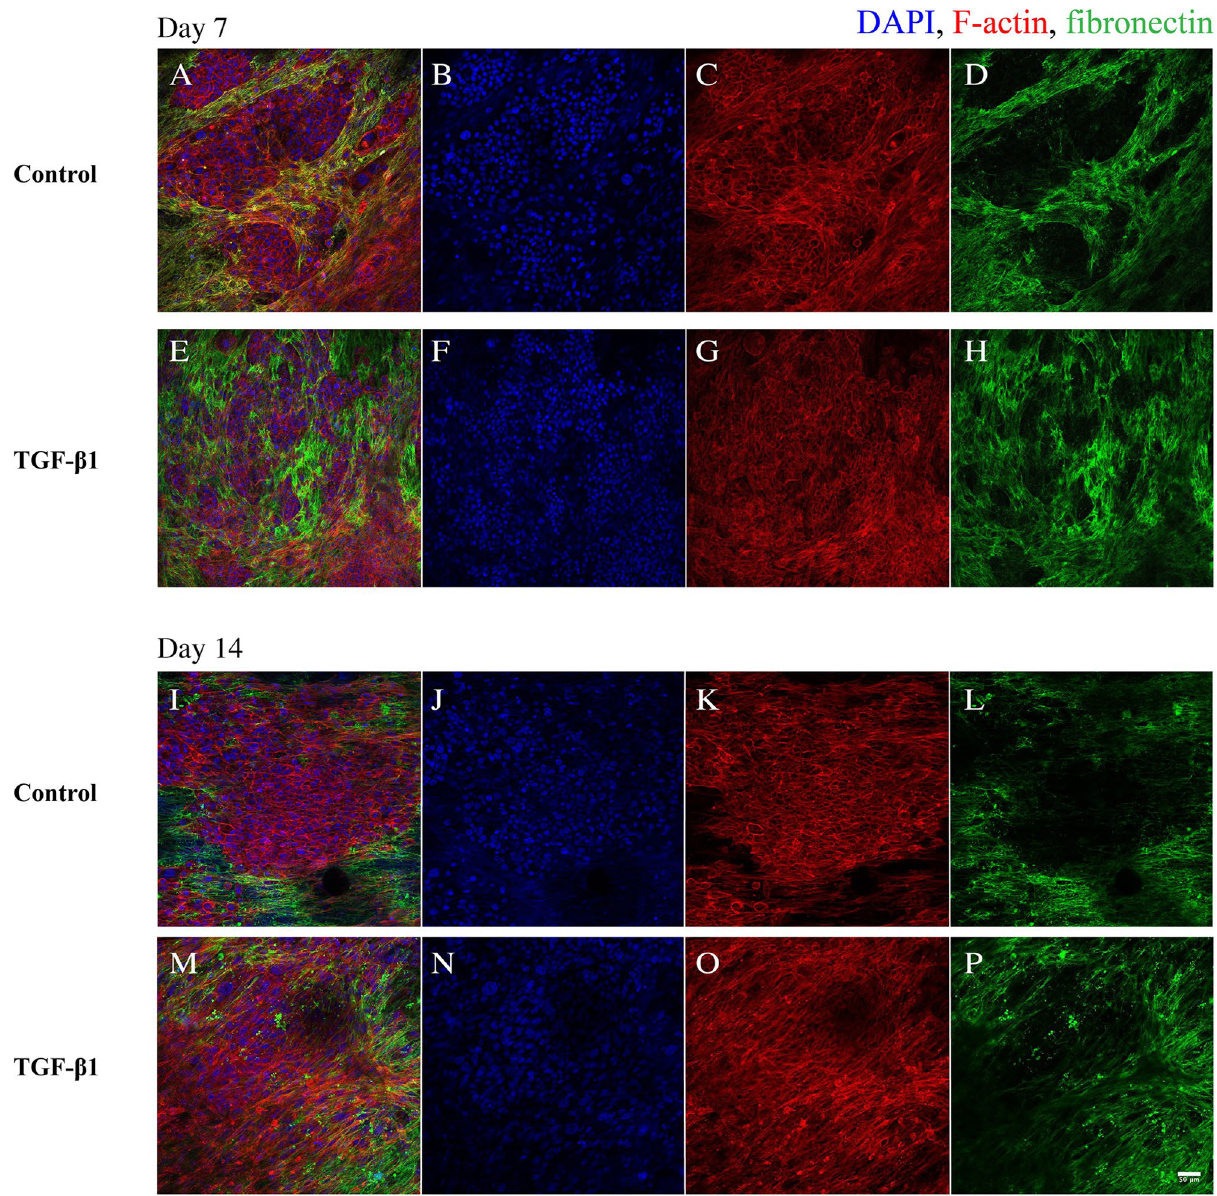
Figure 6. Confocal images of fibronectin localization in JIMT-1/HDF 3D co-cultures in response to TGF-β1 treatment. JIMT-1/HDF 3D co-cultures were incubated in the absence (control, A – D and I – L ) or presence of 5 ng/ml TGF-β1 ( E – H and M – P ) for 7 and 14 days in 3D scaffolds. The co-cultures were fixed in 3.7% formaldehyde and stained to visualize actin filaments (red), fibronectin (green), and cell nuclei (blue) after 7 and 14 days in culture. The images were taken in the centre of 3D cultures. All images are representative of 3 independent experiments. Scale bar is 50